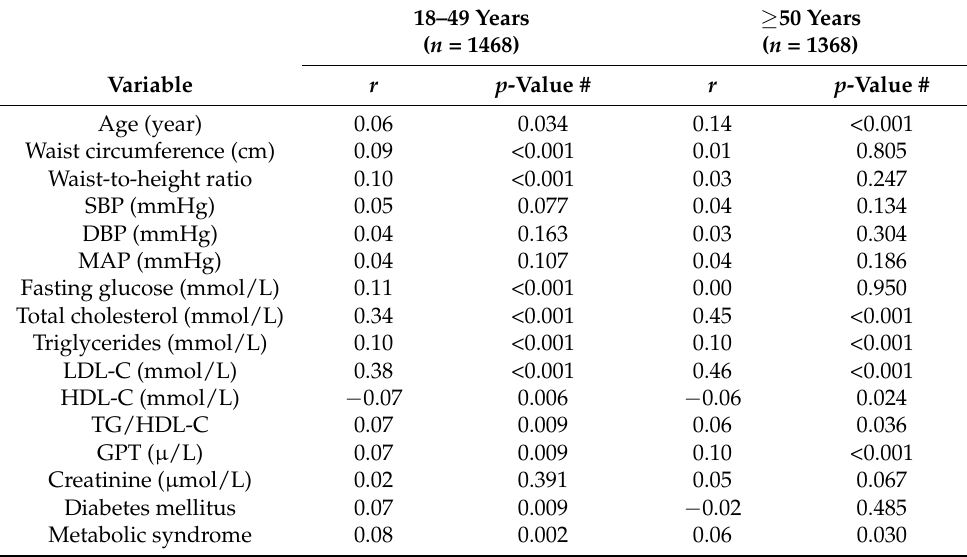
Table 4. Pearson’s correlation coefficients between Lp-PLA2 levels and clinical/metabolic character- istics in women by